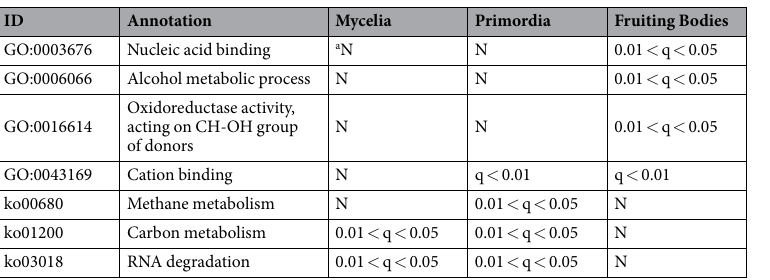
Table 2. List of differentially enriched GO terms and KEGG pathways for SAT pairs expressed in particular developmental stages. N: not significant. a N: not